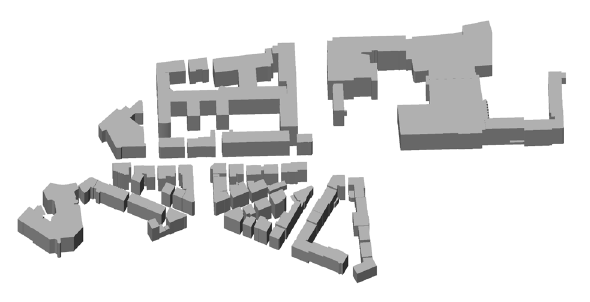
Figure 3. Virtual 3D city model of a building block in Stuttgart (source: Stadtmessungsamt Stuttgart).